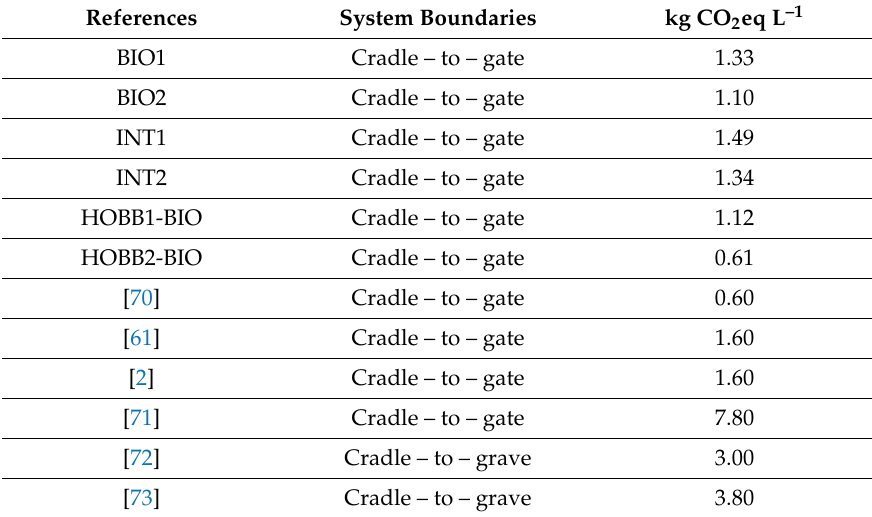
Table 12. Bibliographic comparison between analyzed systems and some similar